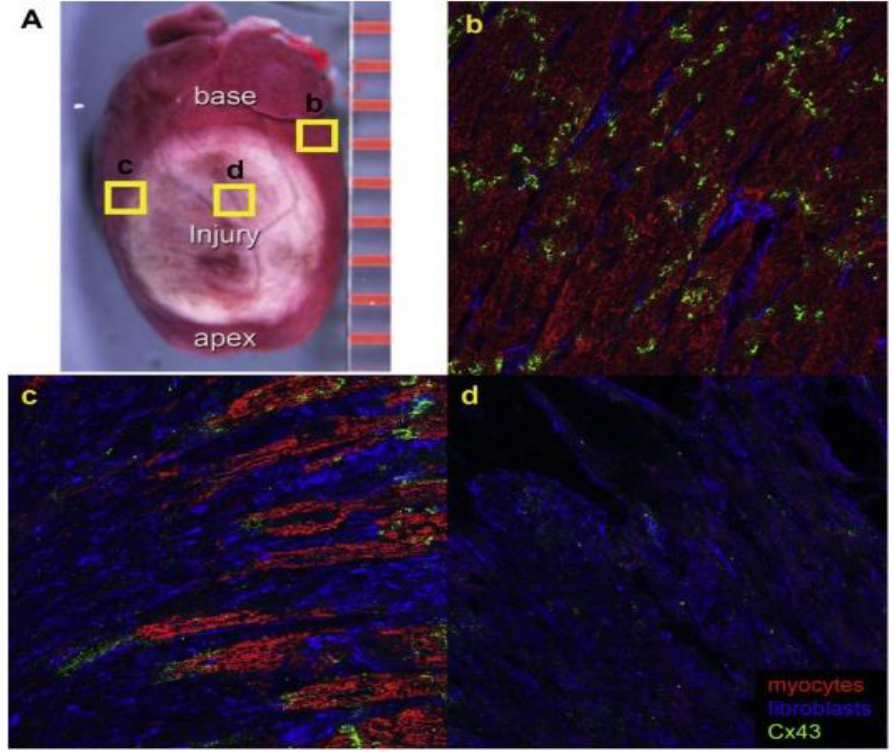
Figure 4. Structural changes in healed infarct scar. ( A ) The scar differentiates in the ischemic portion of the heart. ( b ) Cx 43 (green) is localised to the IDs in remote myocardium. ( c ) Fibroblasts (blue) interrupt normal myocyte (red) connections in the IBZ adjacent to the scar and Cx 43 reorganises away from the IDs. Cx 43 is often found between myocytes and fibroblasts. ( d ) Punctate Cx 43 is found within the scar. Reprinted with permission from [36]. Elsevier, all rights reserved.